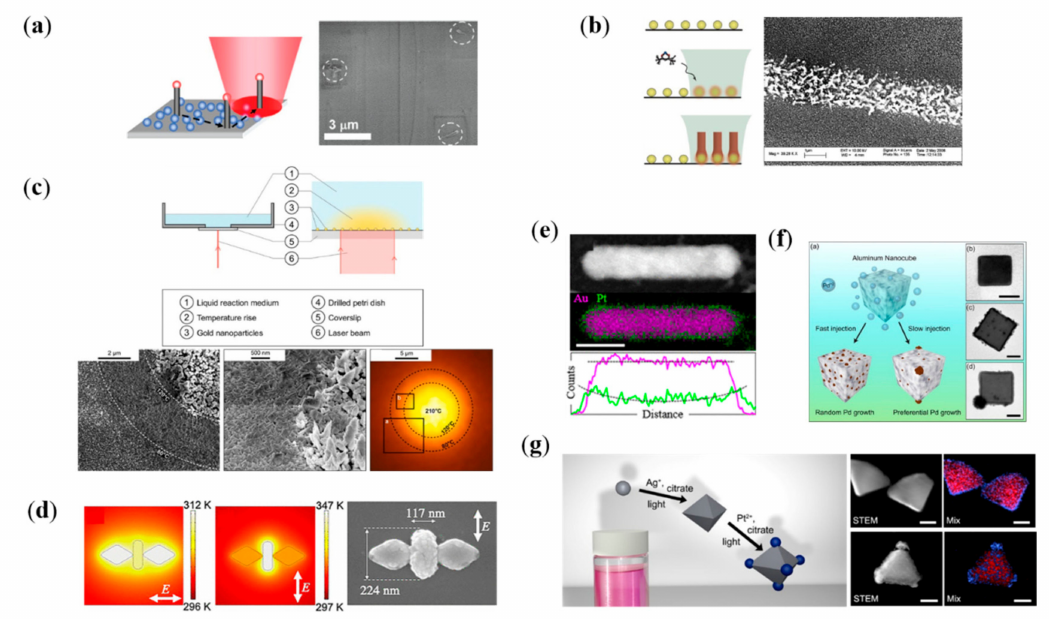
Figure 5. Plasmon-assisted selective deposition of non-plasmonic nanomaterials. ( a , b ) Plasmonic thermal-field-assisted selectively chemical vapor deposition. ( a ) Deposition of semiconductor nanowires/Si nanotubes [80] ( b ) Deposition of PbO/TiO 2 on glass substrates [81]. ( c )